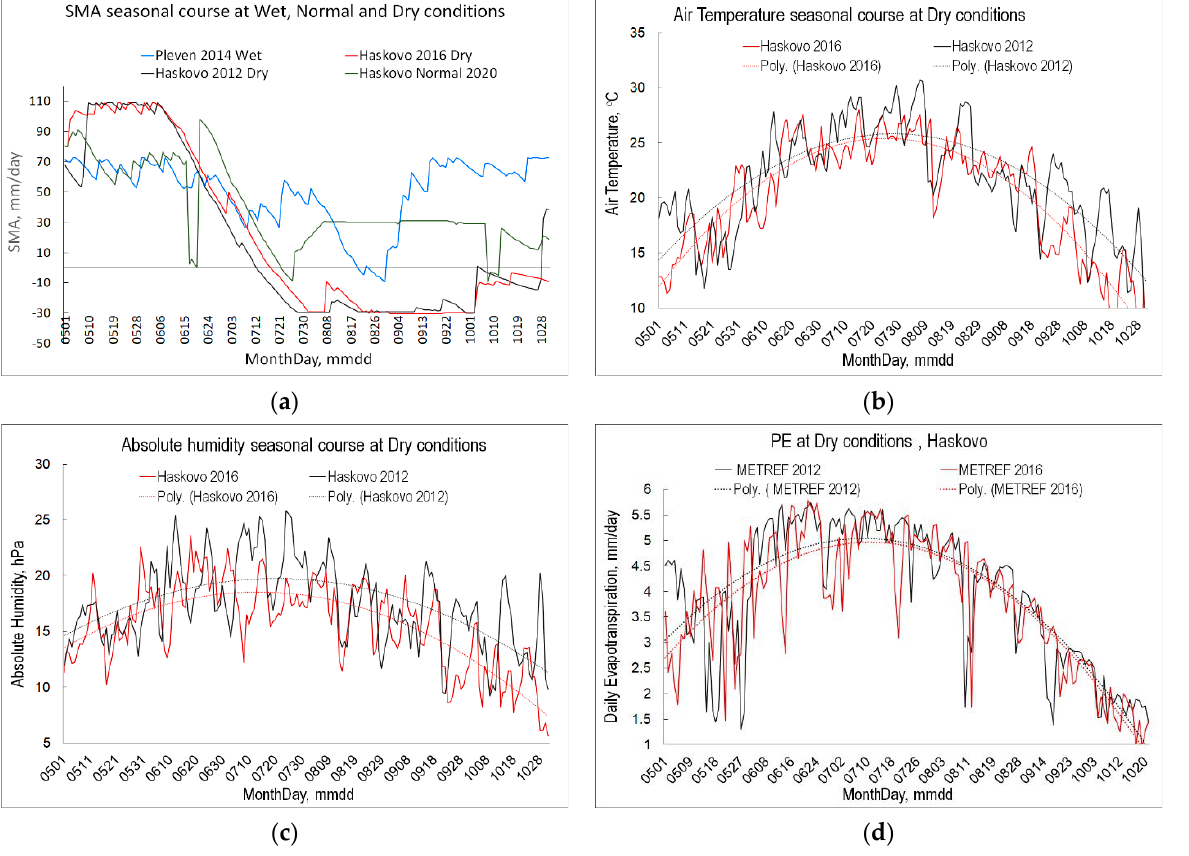
Figure 7. Seasonal (May–October) courses of evapotranspiration drivers (daily values): ( a ) SMA under moist (2014, blue), normal (2020, green), and dry (2012, black, and 2016, red) conditions; ( b ) air temperature; ( c ) absolute humidity; ( d ) PE (METREF) under dry conditions for 2012 (black) and 2016 (red). The polynomial trend lines (dashed) are shown.